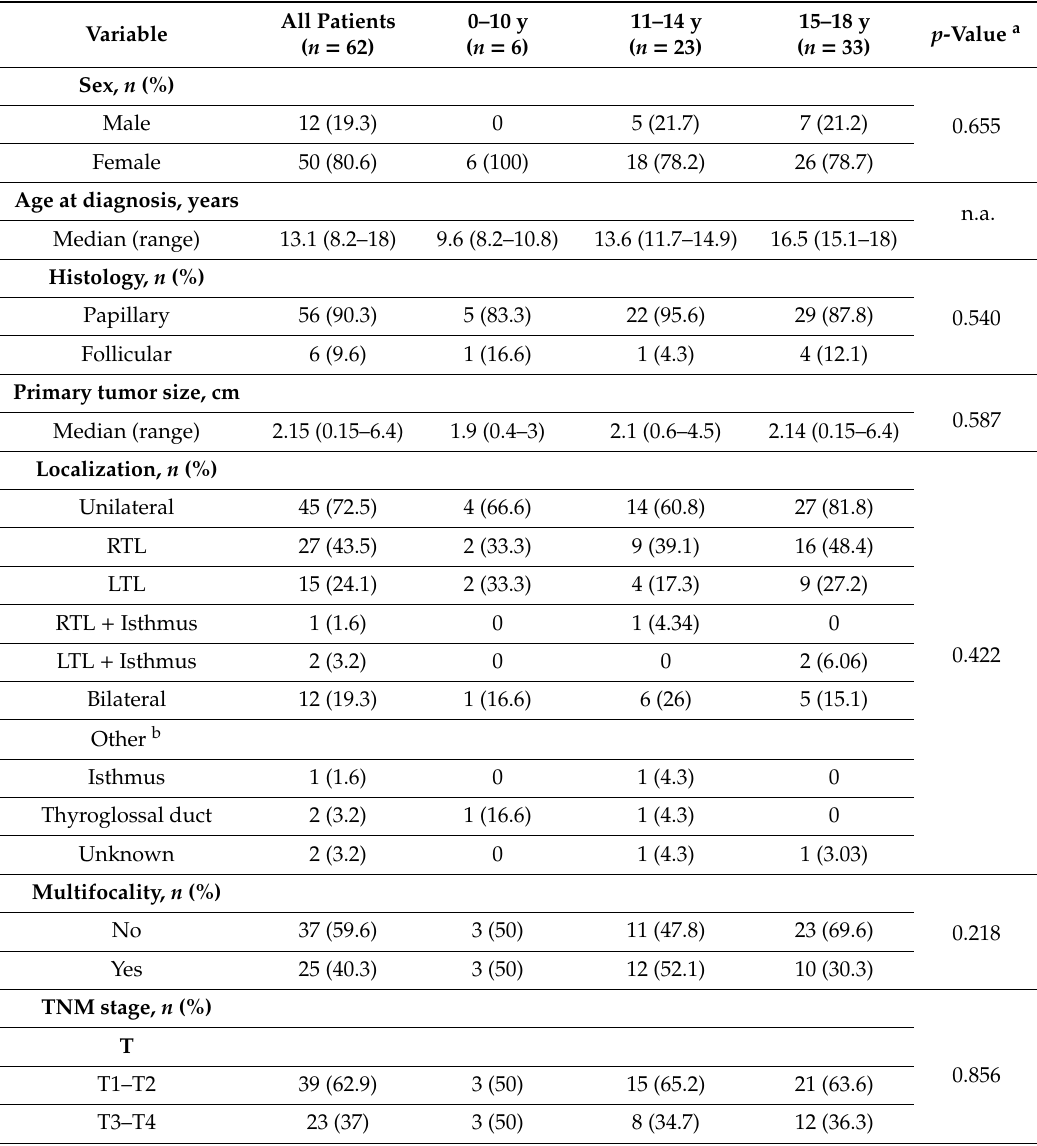
Table 1. Baseline